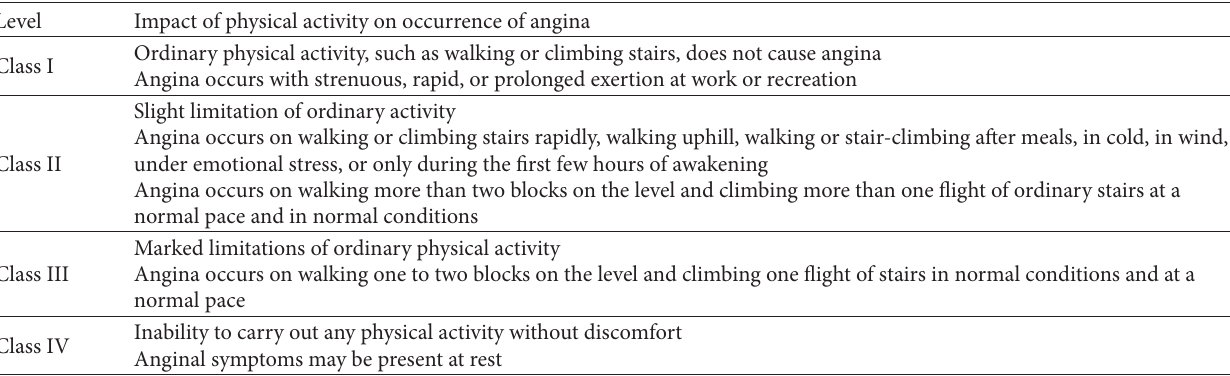
Table 1: Canadian Cardiovascular Society Classification of angina according to impact on physical activity.